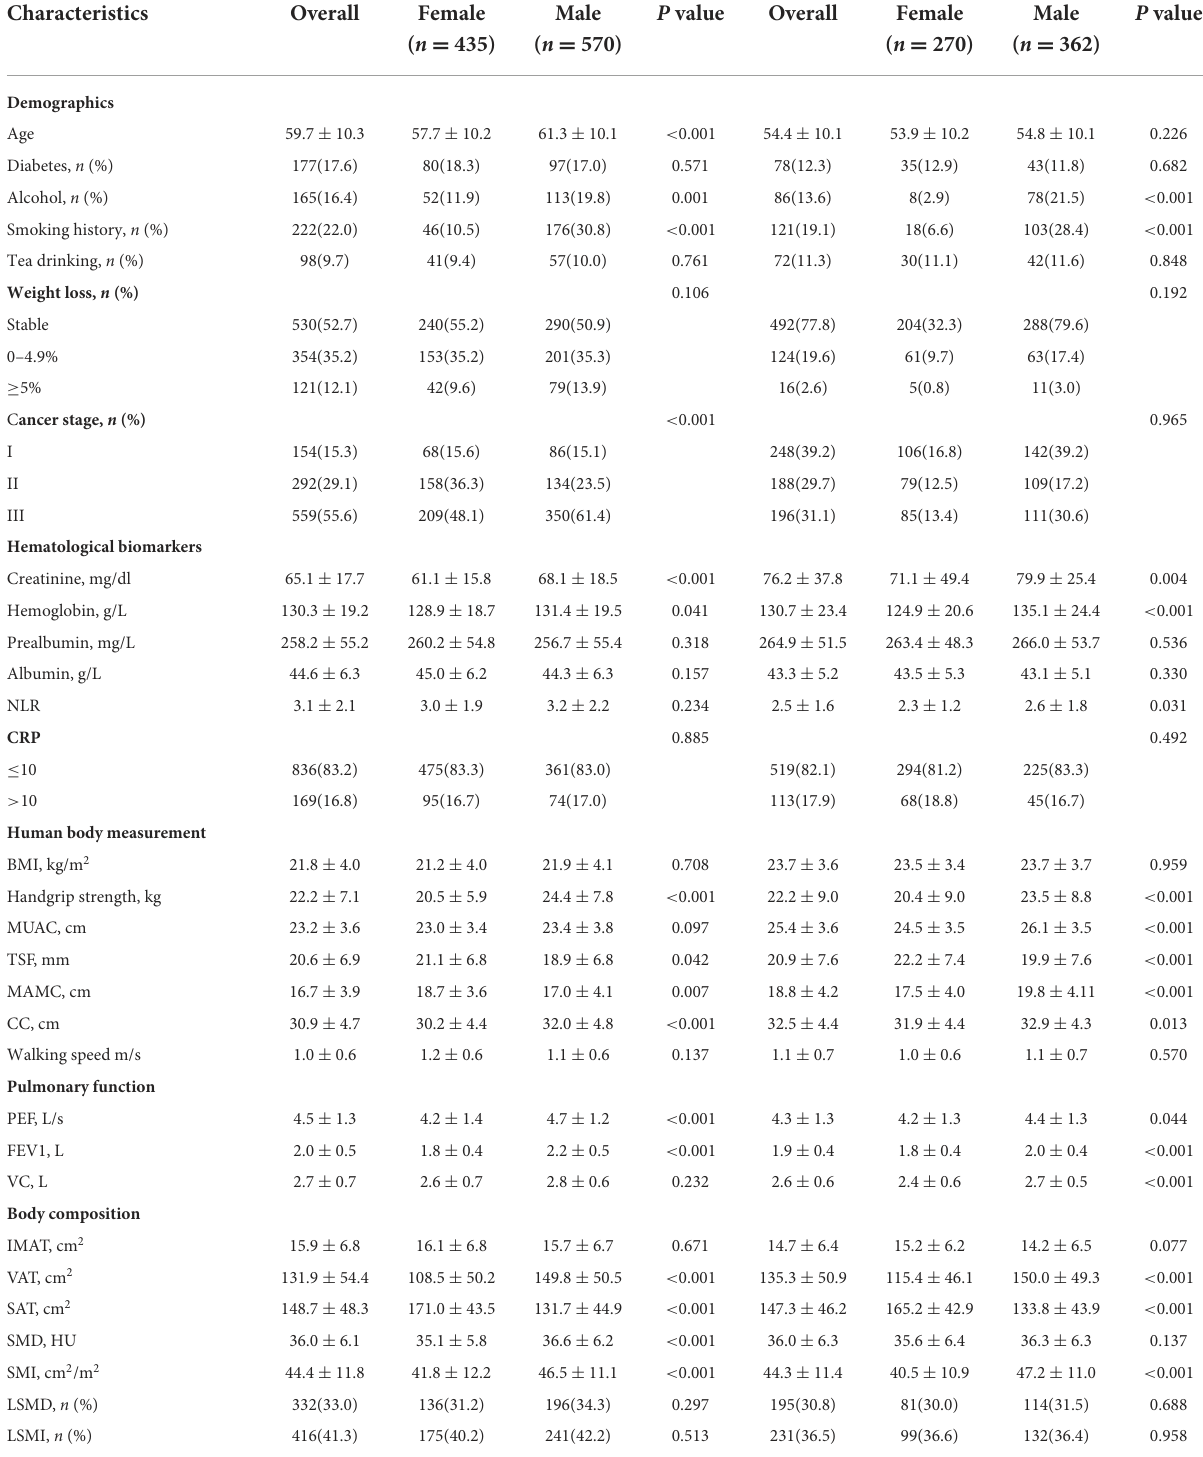
TABLE 1 Baseline characteristics of colorectal patients in the two centers a . Training cohort, n =